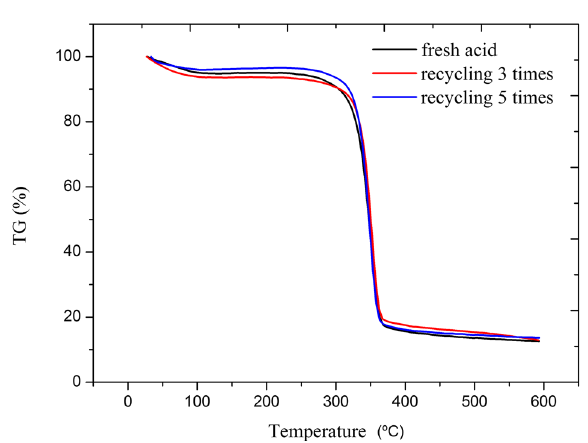
Figure 8: Thermogravimetric (TG) curves of hydrolyzed cellulose after a varied number of waste liquid cycles.